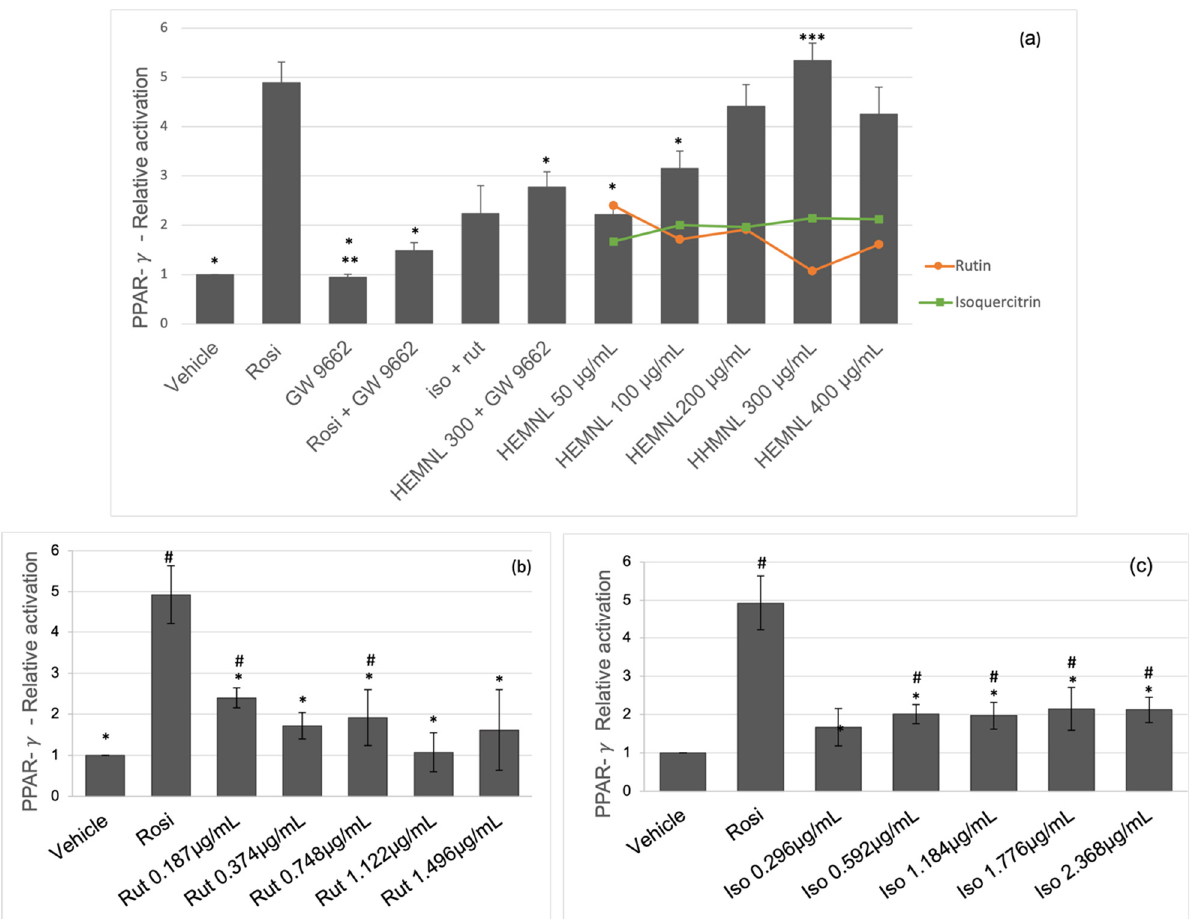
Figure 4. Activation of PPAR- γ evaluated by the Luciferase Reporter Assay. Rosi: Rosiglitazone 10 − 5 M—PPAR- γ agonist; GW 9662 10 − 5 M—PPAR- γ antagonist. Iso + Rut: Isoquercitrin 1.77 µg ∕ mL and rutin 1.12 µg ∕ mL; HEMNL: hydroethanolic extract of Morus nigra leaves; Vehicle: DMEM with 2% of ethanol. ( a ) Activation of PPAR- γ by HEMNL compared to the activation by rutin (orange line) or isoquercitrin (green line) tested separately at concentrations corresponding to their presence in the extract. ( b ) Activation of PPAR- γ by rutin. ( c ) Activation of PPAR- γ by isoquercitrin. Data represent mean ± standard deviation. Statistical analysis performed by one-way ANOVA test followed by Tukey’s post-test. * p < 0.001 in relation to Rosi. ** p < 0.001 in relation to Rosi, HEMNL 300 + GW 9662, HEMNL 50, 100, 200, 300, and 400 µg/mL and iso + rut. *** p < 0.001 in relation to HEMNL 300 + GW 9662, iso + rut, vehicle, GW 9662, HEMNL 50 and 100 µg/mL. # p < 0.05 in relation to vehicle.